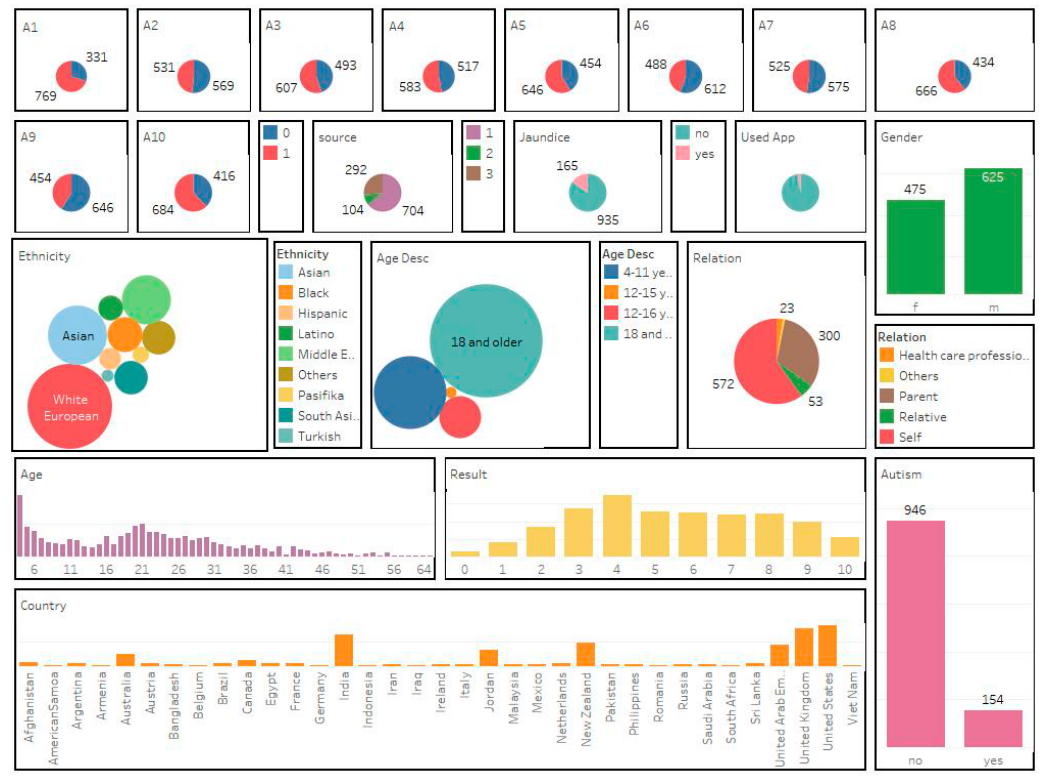
Figure 6. Dashboards describing correlations between autism variables and the final classification.